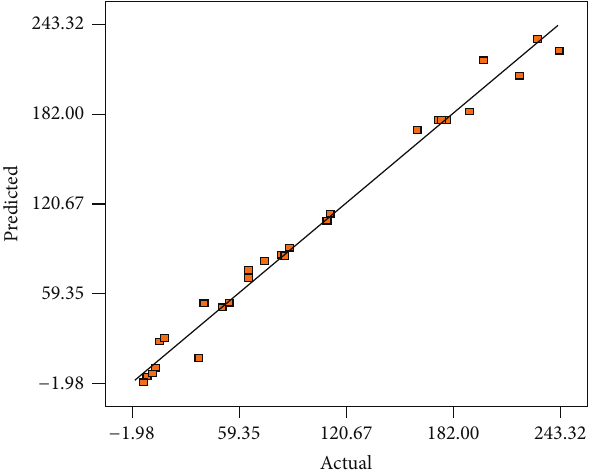
Figure 1: Pareto chart showing the effects of different independent variables on bioethanol yield. Figure 2: Experimental values versus predicted values for the